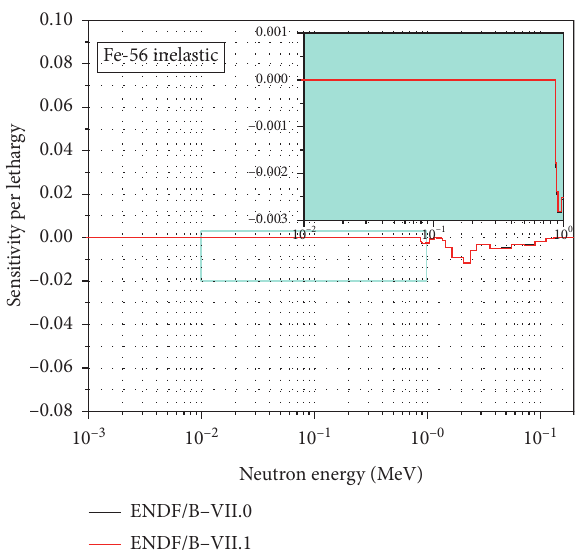
Figure 20: Energy-dependent sensitivities of k